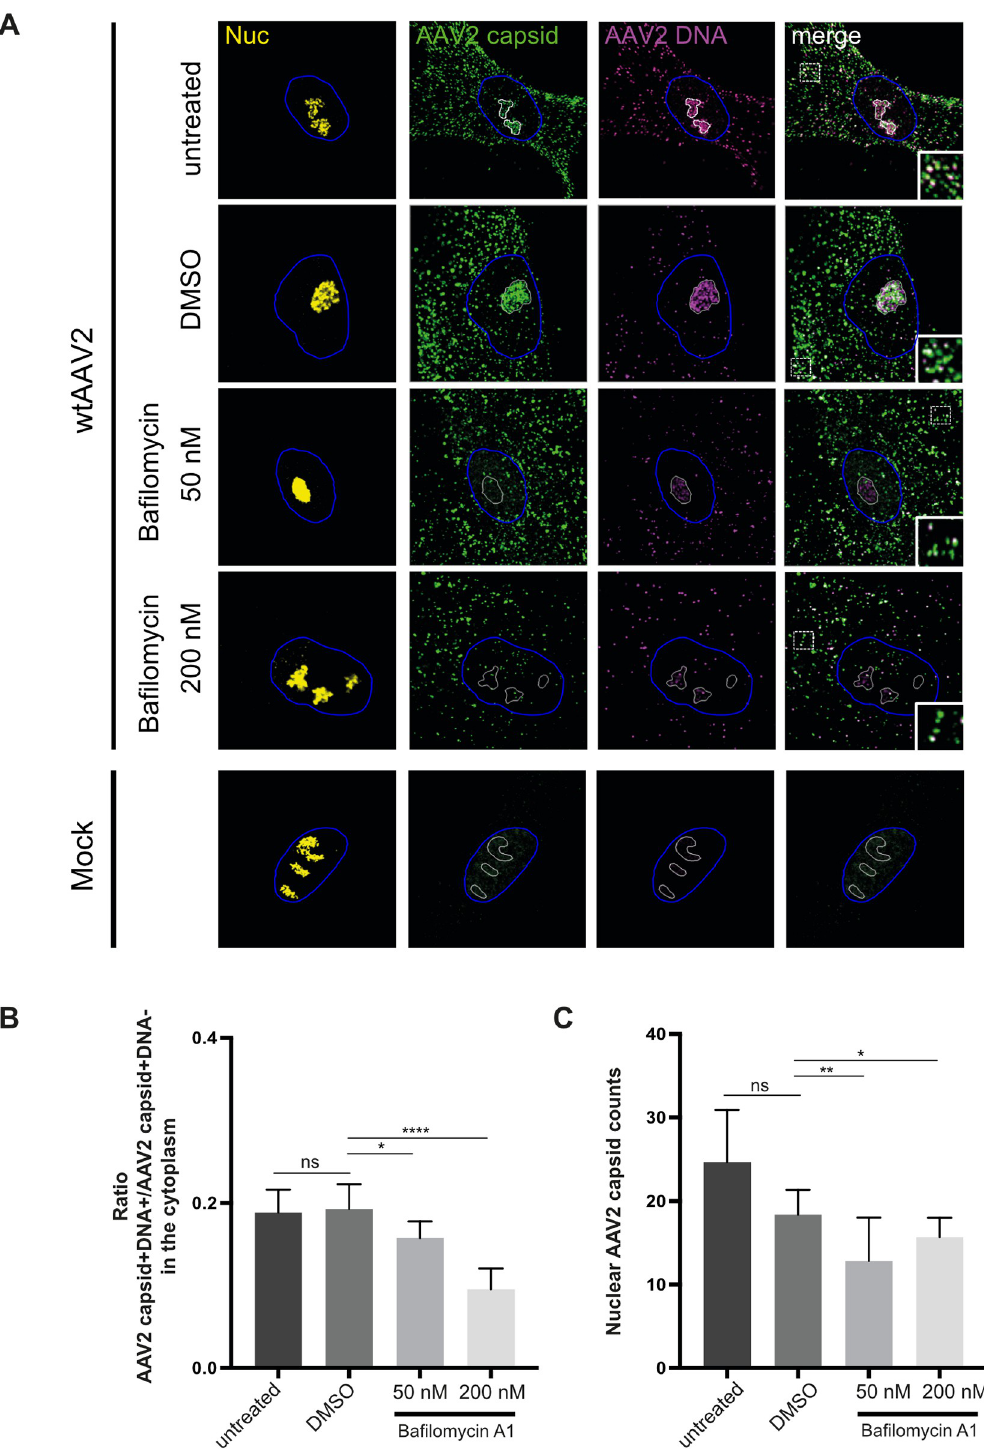
Fig 3. Acidification enhances genome accessibility of AAV2. NHF cells were treated with bafilomycine A1 (50 or 200 nM) or DMSO 1 h prior to infection with wtAAV2 (MOI 20‘000). At 3 hpi, the cells were fixed and processed for multicolor IF analysis combined with FISH and CLSM. Nucleoli (Nuc) were visualized using an antibody against fibrillarin (yellow). Intact capsids were stained using an antibody that detects a conformational capsid epitope (green). AAV2 DNA (magenta) was detected with an Alexa Fluor (AF) 647 labeled, amine-modified DNA probe that binds to the AAV2 genome. (A) Genome